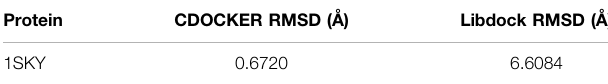
TABLE 1 | Validation of molecular docking algorithm